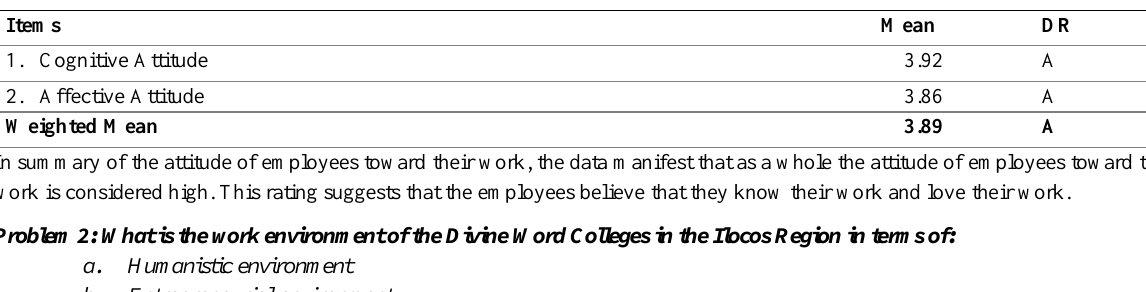
Table 3: Summary of Attitude of Employees toward their Work